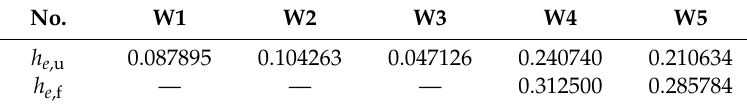
Table 7. Equivalent viscous damping coe ffi cients of all